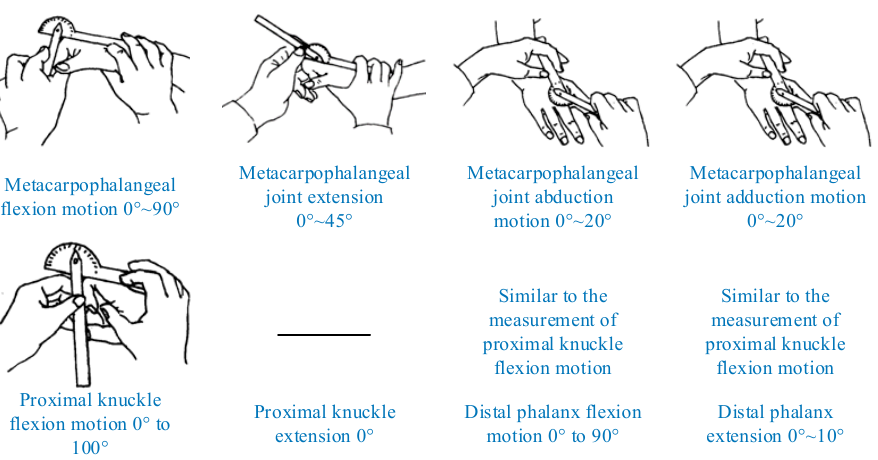
Figure 1. Structural components of the human hand.